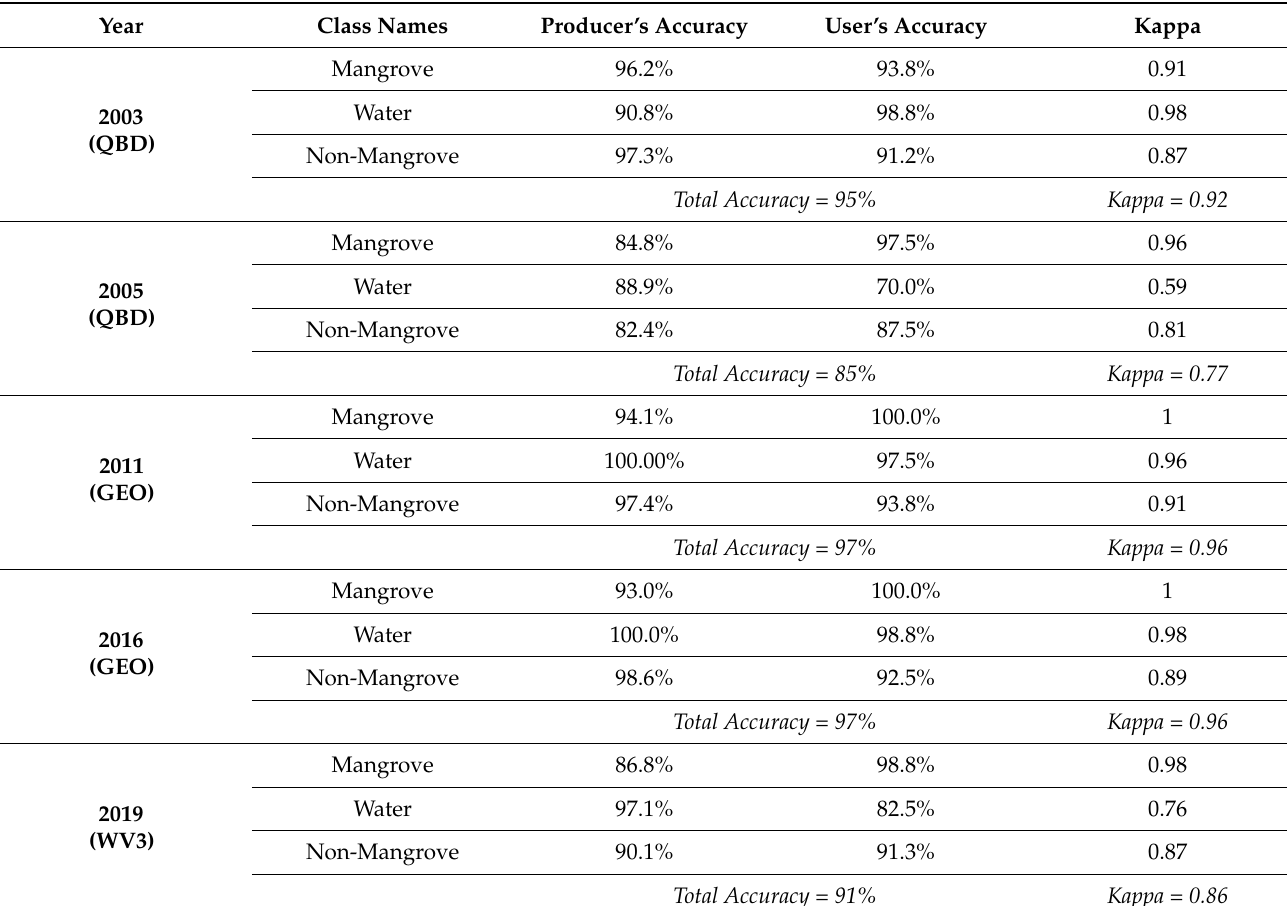
Table 2. Classification accuracies of individual land-cover classes for Pichavaram, as obtained from the supervised classification of the VHSR images (QBD = Quickbird; GEO = GeoEye-1; WV3 =